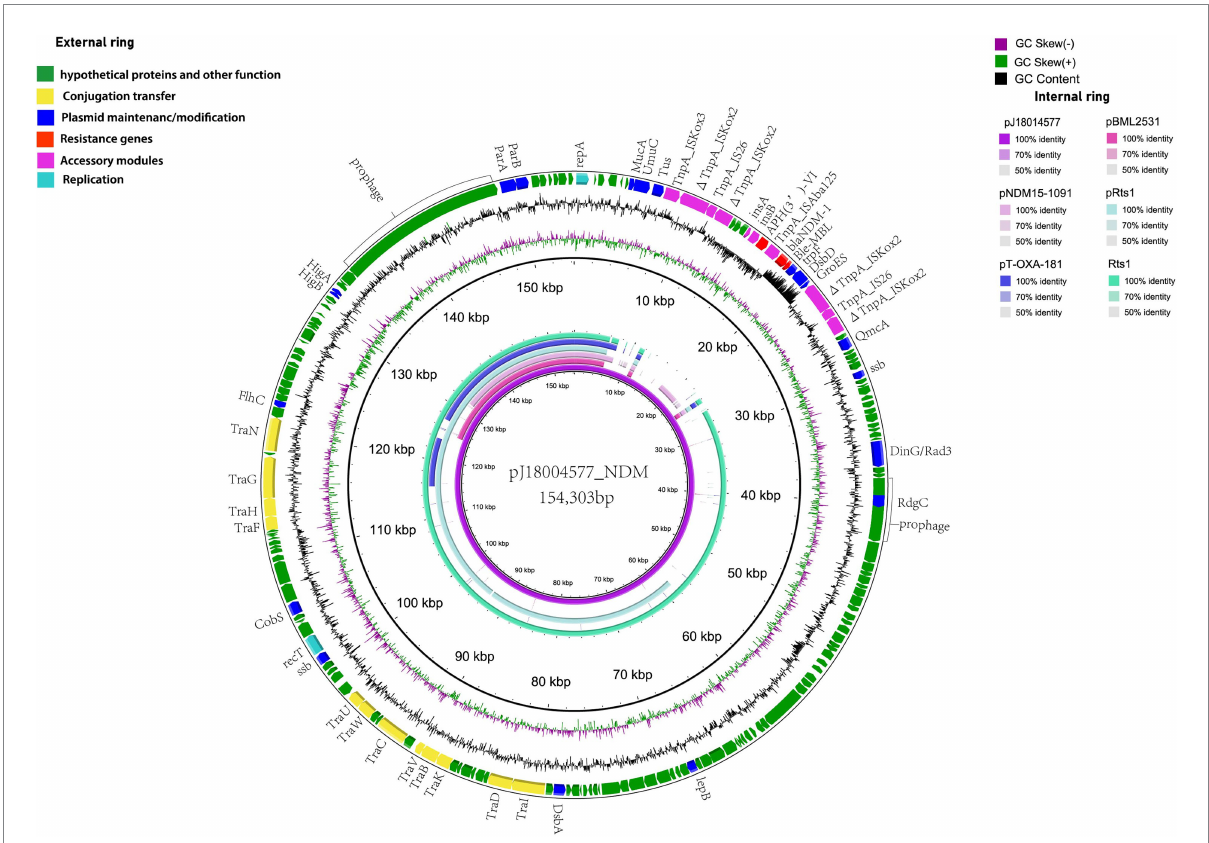
FIGURE 3 Comparisons of genetic context of pJ18004577_NDM with similar plasmids. Red and purple arrows represent antibiotic resistance genes and accessory modules, respectively. The features of the variable region (at 8,779–24,607 bp) shared high homology with the bla NDM-1 -containing region of p18004577_NDM, and the backbone region was almost identical to that of